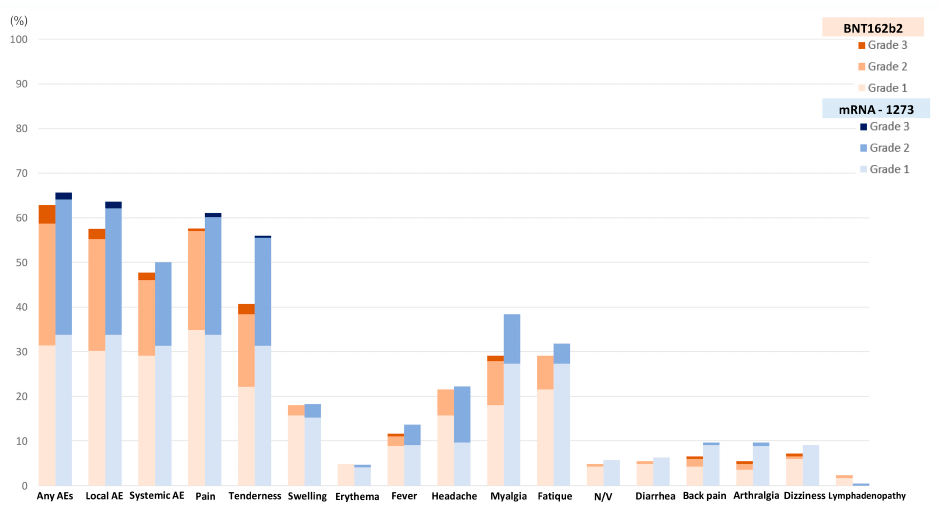
Figure 1. Incidence of adverse events following the booster dose with the BNT162b2 as compared to the mRNA-1273 vaccine.